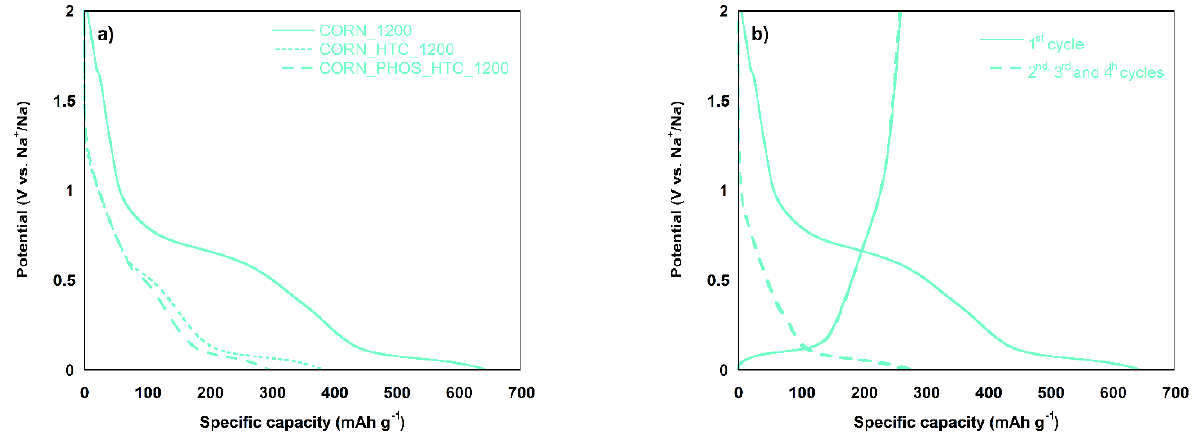
Figure 5. Electrochemical performance of the first discharge cycle of CORN_1200, CORN_HTC_1200 and CORN_PHOS_HTC_1200 ( a ) and the first charge/discharge and subsequent cycles of CORN_1200 ( b ) at C/15.